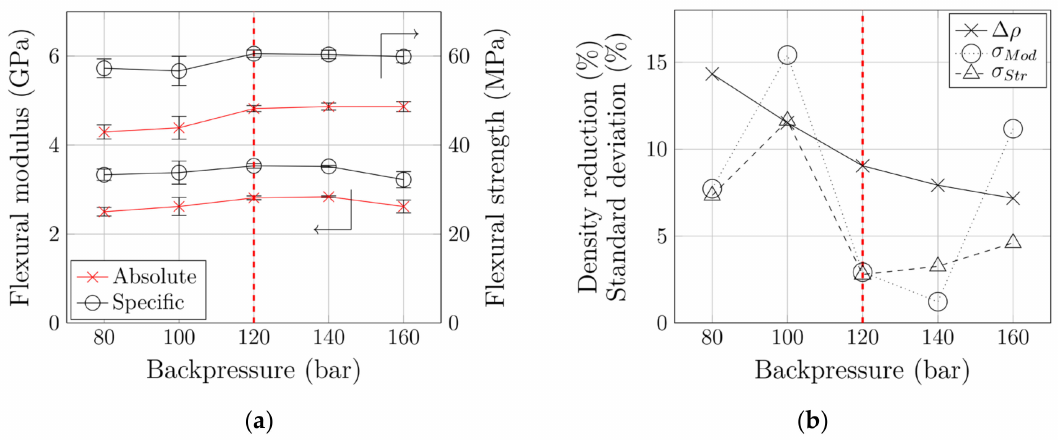
Figure 6. ( a ) Flexural properties of foamed PGC 2 and ( b ) assessment of potential for light weight and process stability at various backpressures. Dashed vertical line: